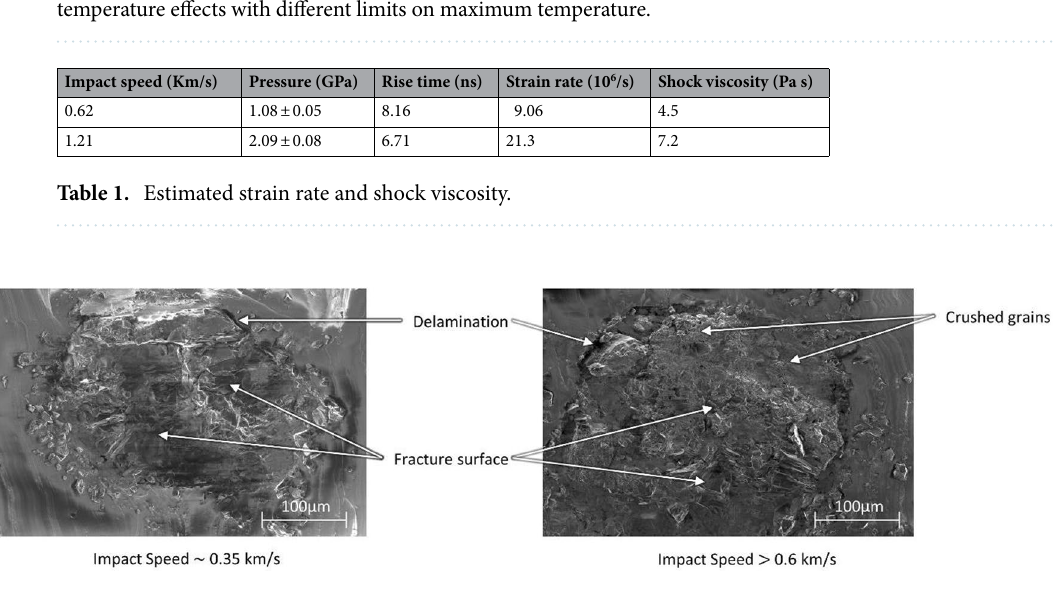
Figure 6. Scanning electron microscopy images of sucrose crystal post-impact at 0.35 km/s and higher than 0.6 km/s. The increase in impact velocity shows severe crushing and compaction of sucrose